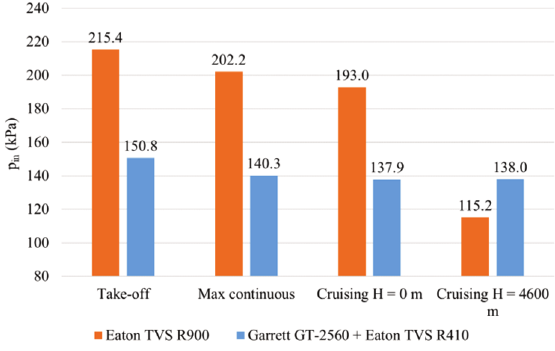
Fig. 7. Comparison of inlet manifold pressure for two analyzed variants